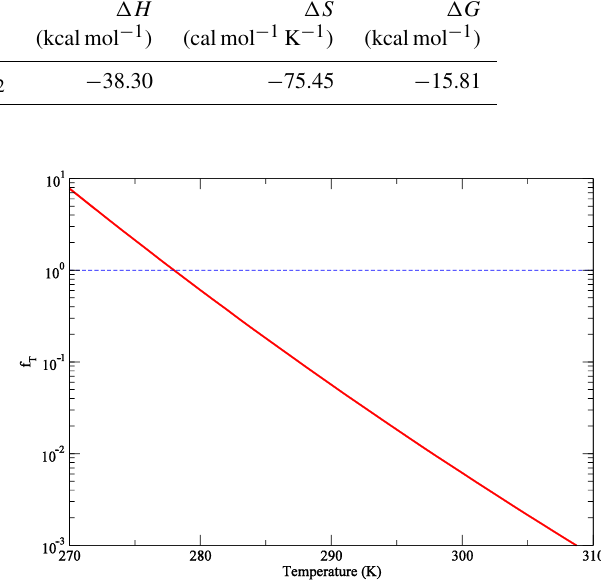
Figure 2. The calculated temperature dependence correction factor for Nucl-Org parameterization ( f T ) as a function of T